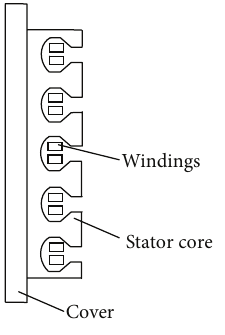
Figure 3: Stator system of axial flux PMSM.